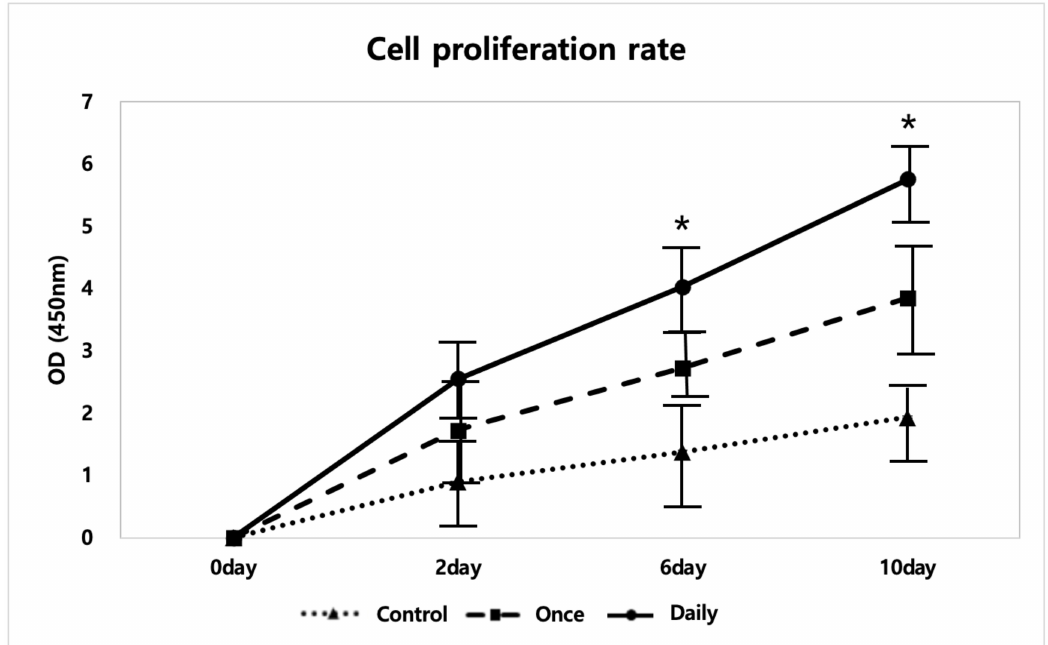
Figure 1. Cell proliferation evaluation of tenocytes at di ff erent time points of substance P (SP) treatment. Data are represented as mean ± standard deviation. Kruskal-Wallis test with Tukey’s post-hoc test was used for statistical evaluation. n = 3. * p <